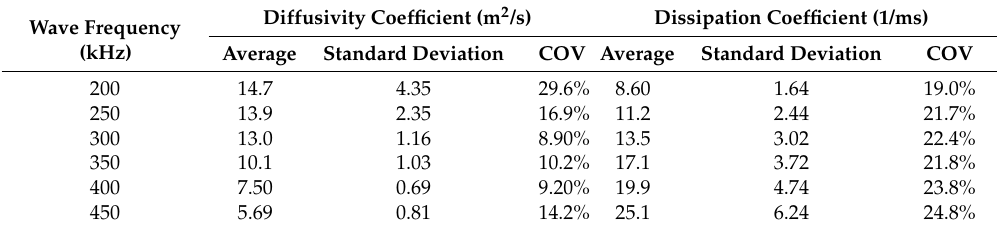
Table 1. Variance of ultrasonic diffusivity and dissipation according to wave